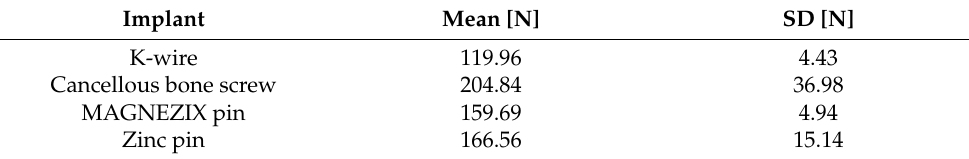
Table 2. Maximum forces measured in shear testing with mean and standard deviation (SD).